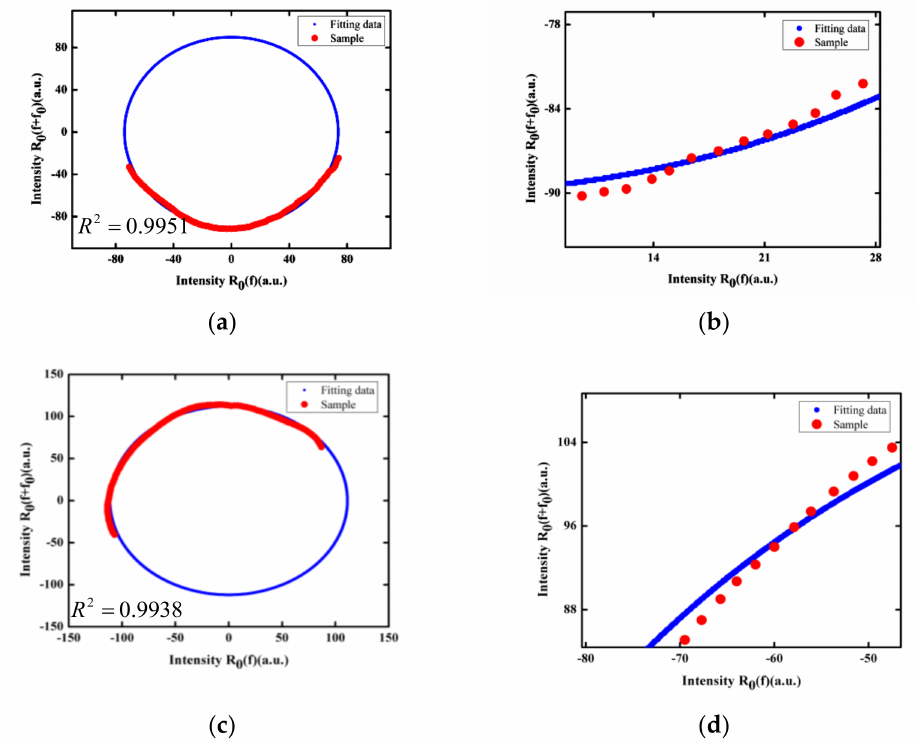
Figure 6. Improved elliptical fitting for the two fabricated fiber FP sensors. ( a ) Lissajous figure of the experimental data and fitting curve, ( b ) detailed view for the cavity length of 20.16 µ m; ( c ) Lissajous figure of the experimental data and fitting curve, ( d ) detailed view for the cavity length of 28.90 µ